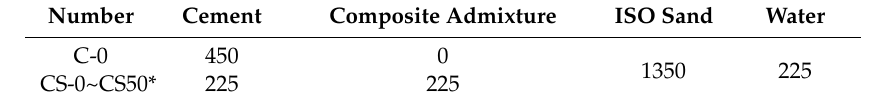
Table 9. Mixing proportion of cement mortar / g.